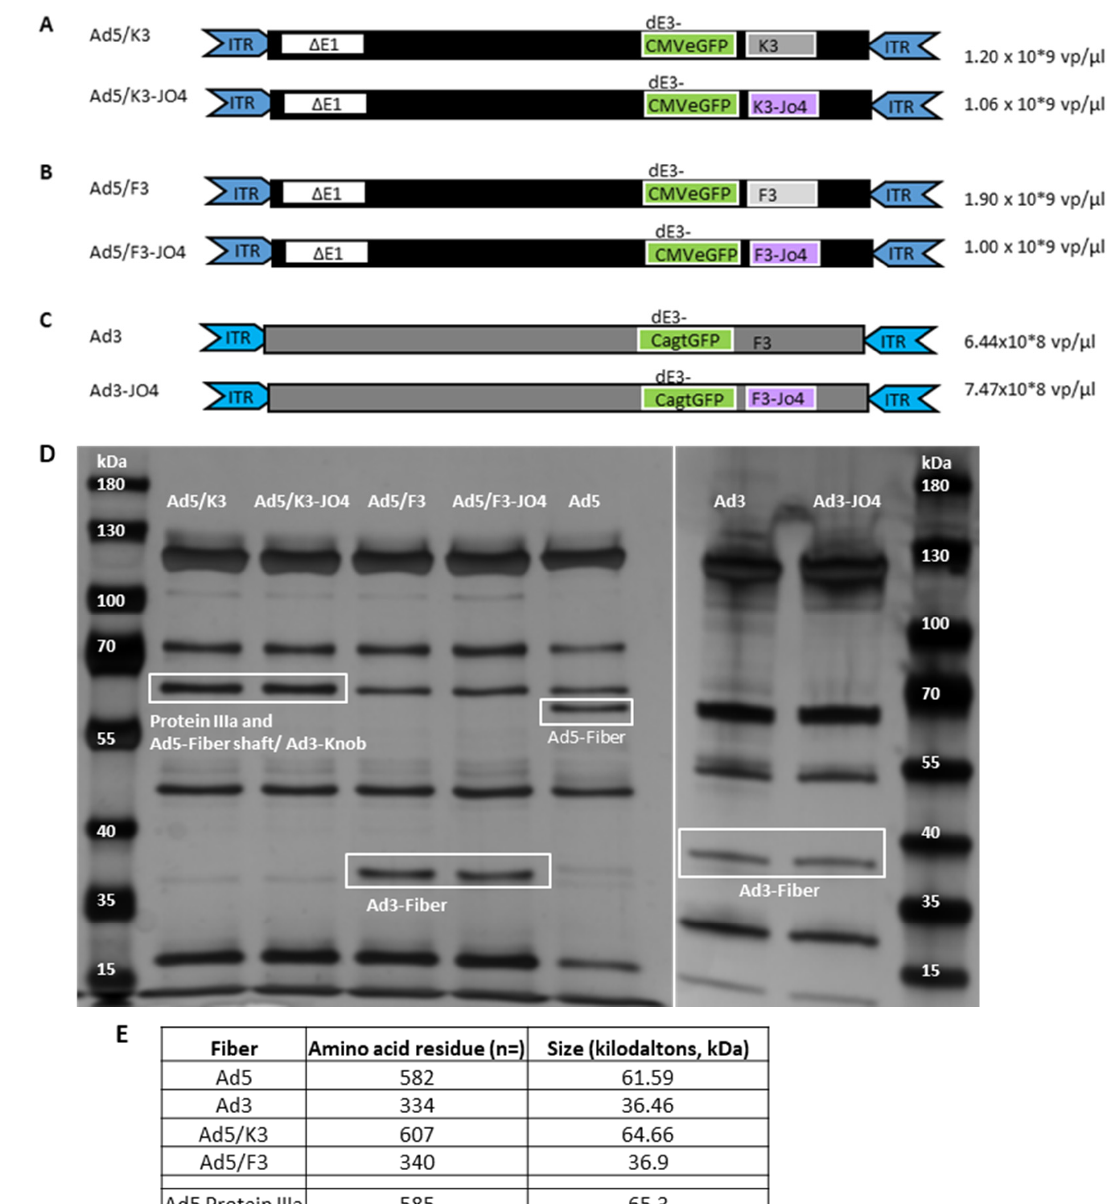
Figure 1. Construction of viral vectors containing the JO4 mutation. The JO4 vectors and parental vectors are presented as follows: ( A ) Ad5-long fiber shaft with Ad3 fiber knob (Ad5/K3) and Ad5/K3-JO4; ( B ) Ad5 with short fiber shaft from Ad3 and Ad3 fiber knob (Ad5/F3) and Ad5/F3-JO4; ( C ) Ad3 and Ad3-JO4 are Ad3-based vectors. All vectors contain a green fluorescent protein (GFP) expression cassette inserted in the E3-region. Ad3 and Ad3-JO4 are replication-competent viruses with the same phenotype as the wild-type virus, while ( A , B ) are nonreplicating vectors with an E1 deletion. The physical titers of each virus are shown on the right . ( D ) Adenovirus protein detection in silver gel. Fiber proteins are highlighted in labeled rectangles. Note that for Ad5/K3 and Ad5/K3-JO4, the fiber protein is displayed in the same position as Ad5 protein IIIa, demonstrated as relatively strong bands at this position (~65 kDa) compared with Ad5/F3 and Ad5/F3-JO4. The numbers of fiber amino acid residues and sizes are listed in ( E